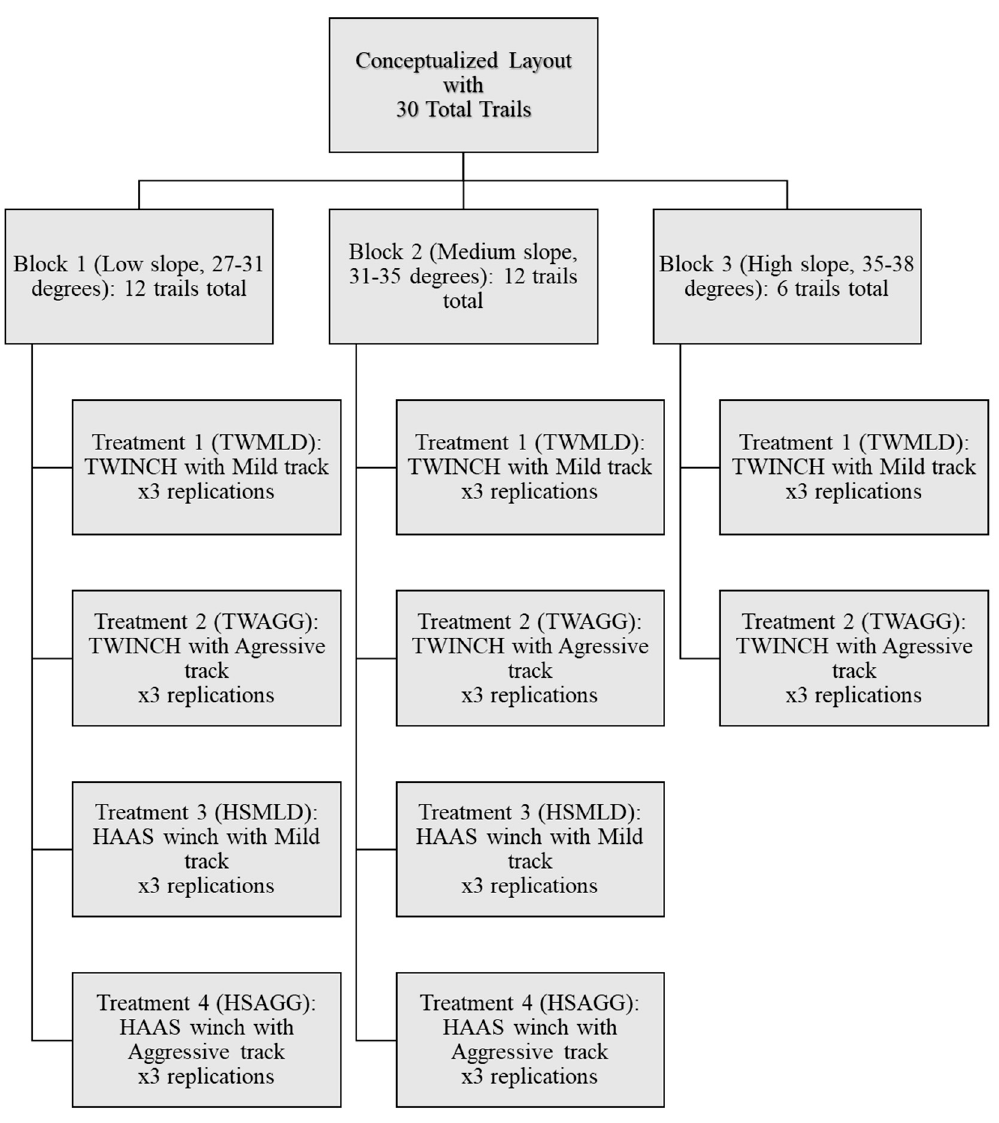
Figure 4. Conceptualized experimental design layout with 30 total trails.